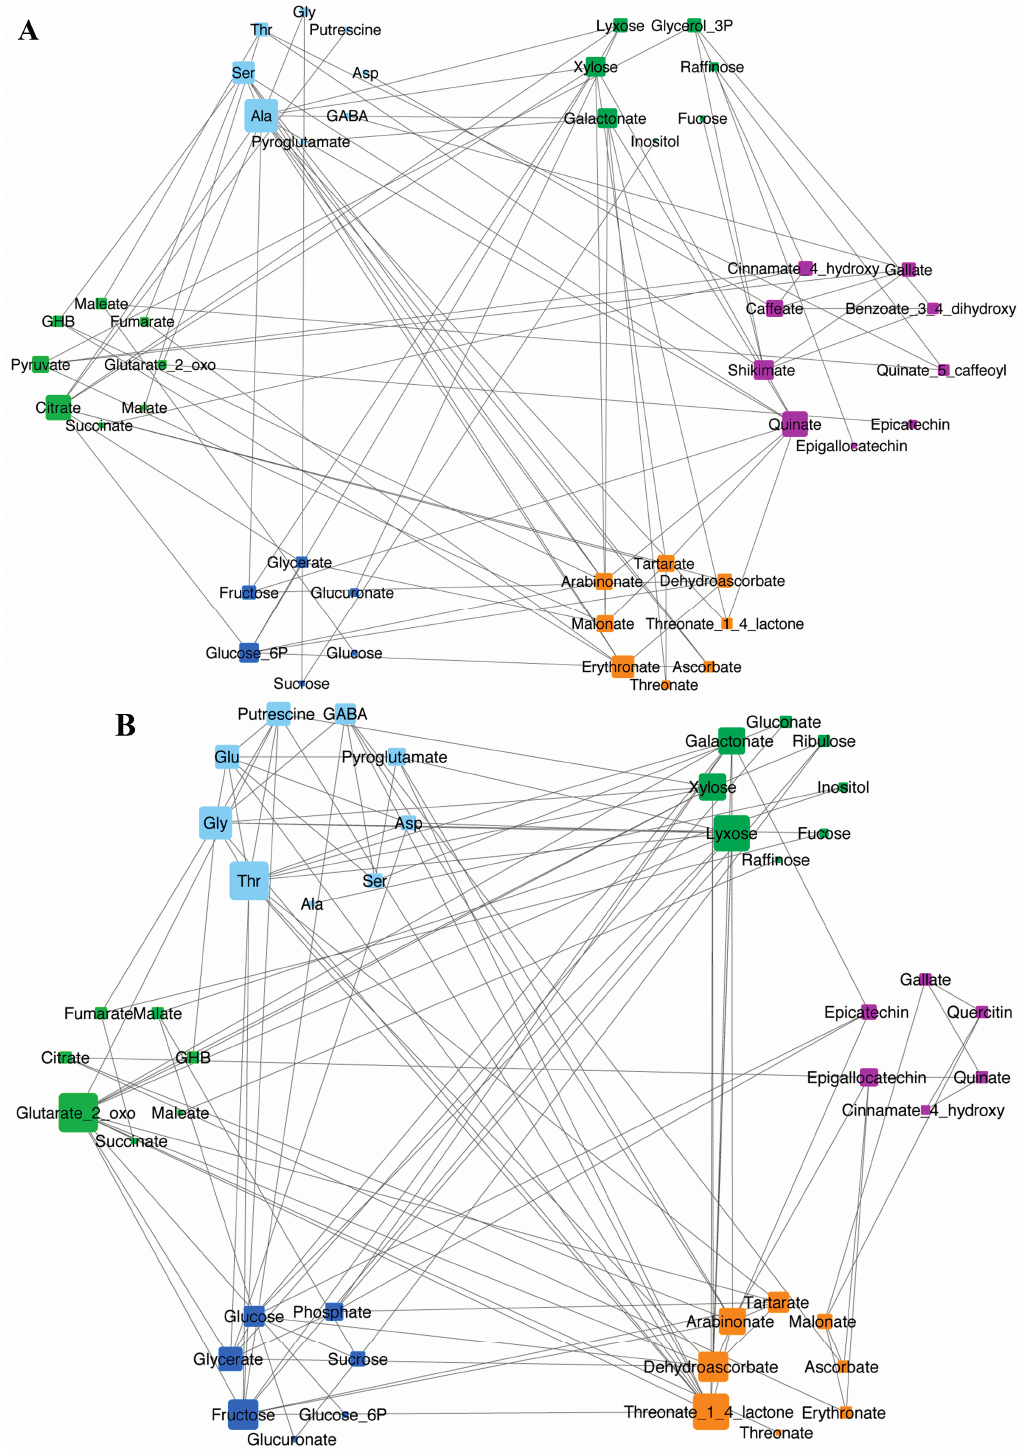
Figure 3. The metabolic networks of Cs ( A ) and Sh ( B ) varieties built based on Spearman’s rank correlation. Each node represents a metabolite, each edge—significant correlation between pairs of metabolites, unique for each variety. The size of nodes represent nodal degree from 1—the smallest to 11 ( A ) or 12 ( B )—the largest. The color code of the nodes represent the metabolic pathway affiliation: amino acid metabolism (blue), glycolysis (navy), TCA cycle (light green), non-glycolytic sugars (dark green), flavonoids pathways (purple) and carboxylic acids